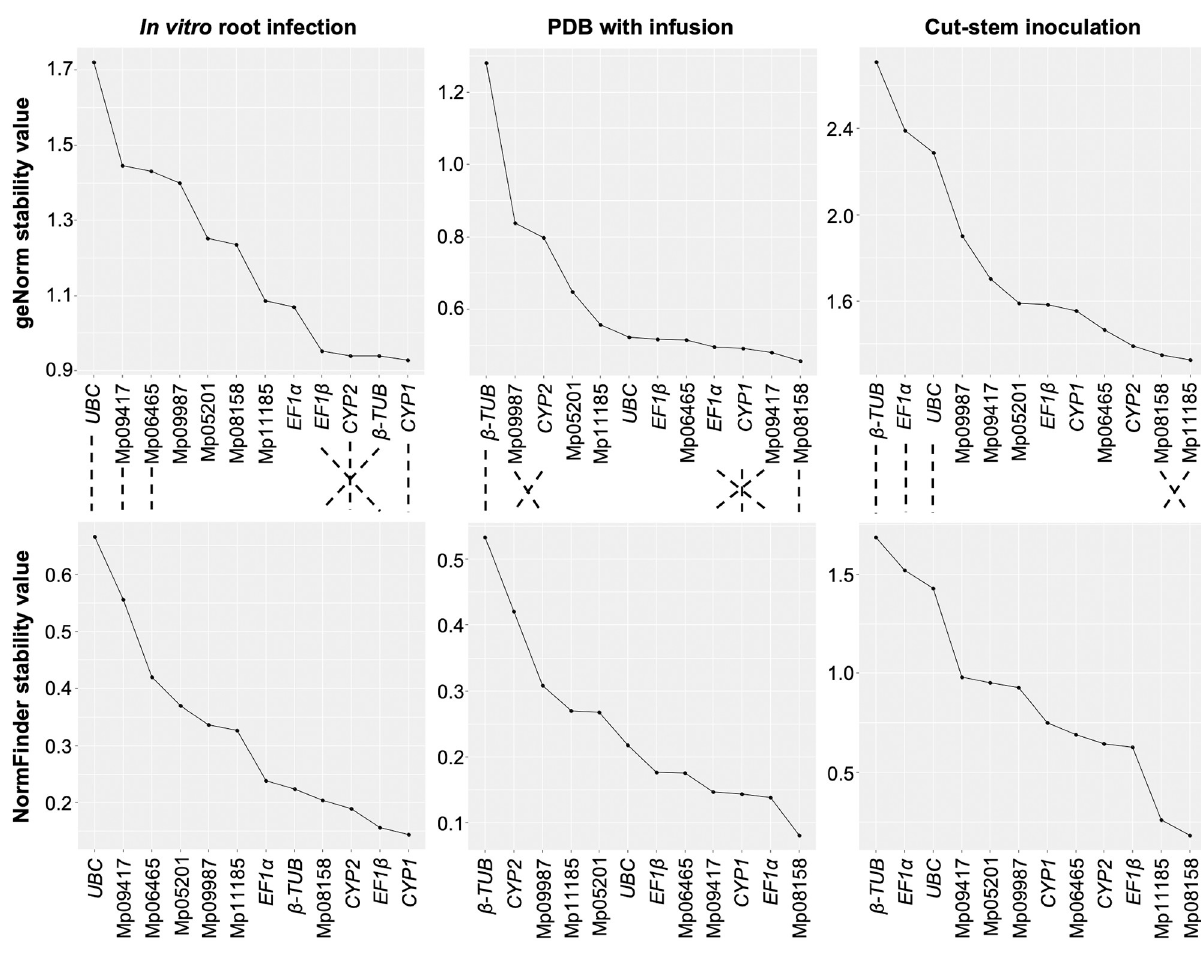
Fig 2. Expression stability of 12 candidate reference genes in M . phaseolina evaluated by geNorm and NormFinder algorithms. Stability of M . phaseolina genes in infected soybean roots ( in vitro root infection method) (left), growth in PDB with leaf infusion (middle) and infected soybean stems (cut-stem inoculation method) (right) were determined using geNorm (top) and NormFinder (bottom) algorithms. Only the most and least stable genes between the two algorithms are connected by